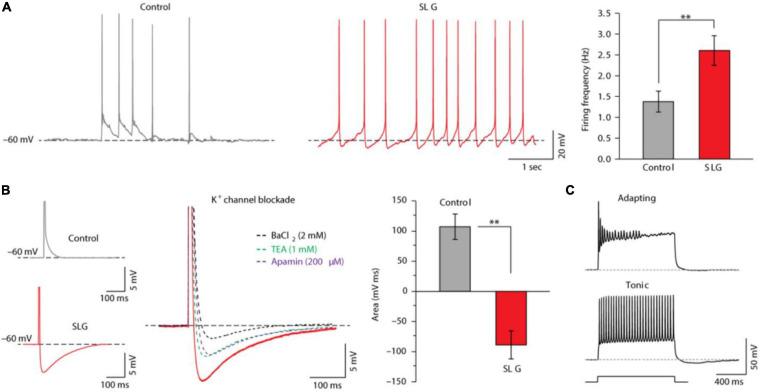
SLG triggers changes in single-cell intrinsic excitability. (A) Representative current-clamp recordings of hippocampal neurons in culture (10 DIV) in control and SLG. Control and SLG neurons displayed similar resting membrane potentials (–52 ± 10 mV in SLG; –50 ± 7 mV in control). When held at –60 mV, the cell’s spontaneous action potential firing was measured as summarized in the histograms (right). Note the significantly higher action potential frequency in SLG [(2.60 ± 0.36) Hz in SLG, n = 21; (1.37 ± 0.26) Hz in control, n = 19; P = 0.0054]. Significance: **P < 0.01. (B) Evoked single action potential in control (top) and SLG (bottom). Note the pronounced AHP in SLG neurons, which was partially abolished by each of the treatments shown: BaCl2, tetra-ethylammonium (TEA) or apamin (right, superimposed tracings). The histogram quantifies the area below the control and SLG post-AP voltage trajectories with respect to the resting membrane potential. The AHP in SLG neurons was significantly different from the ADP detected in control neurons [(–86.96 ± 23.60) mV ms in SLG, n = 25; (+107.12 ± 21.85) mV ms in control, n = 20; P = 0.0010]. Interestingly, the AHP was reduced (by 88%) by bath-applying Ba2+ (BaCl2, 2 mM; n = 3), which is known to block Kir (inward-rectifier) and KCa (calcium-activated) membrane potassium channels (Alger and Nicoll, 1980;
Jiang and MacKinnon, 2000;
Alagem et al., 2001). The AHP was also reduced (by 58%) by bath-applying TEA (1 mM; n = 9), a non-selective blocker of the large majority of voltage-gated K+ membrane channels (Kv) 47, including BKCa channels (Hille, 2001). Finally, apamin (200 μ M; n = 5), a specific inhibitor of SKCa membrane channels (Hille, 2001), also strongly affected the AHP (47% reduction). (C) Current-clamp recordings from neurons in control and SLG revealed different cell-discharge patterns, classified as adapting or tonic. Reprinted from Pampaloni et al. (2018) Springer Nature.